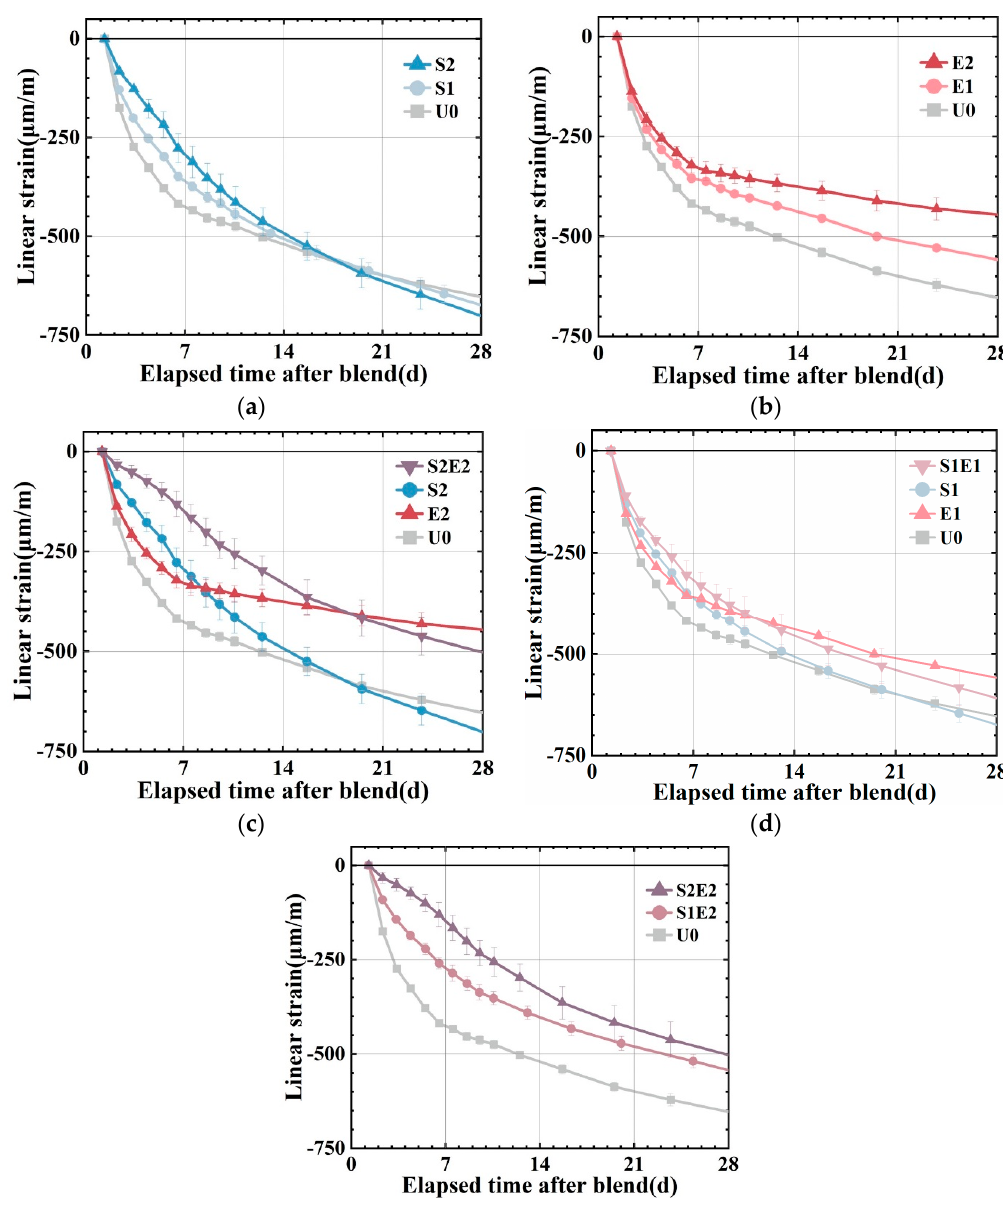
Figure 5. Autogenous shrinkage of UHPC matrix (1.3–28 d). ( a ) Deformation of matrix with SAP. ( b ) Deformation of matrix with CEA. ( c ) Deformation of S2E2. ( d ) Deformation of S1E1. ( e ) Different curing level in matrix with hybrid use of CEA and SAP.